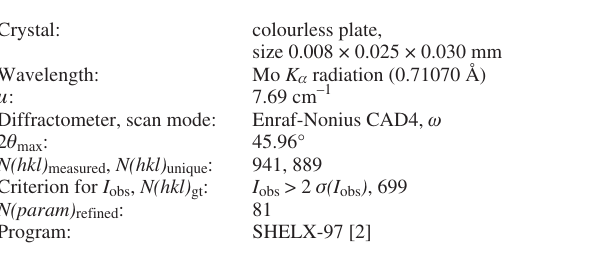
Table 1. Data collection and handling.